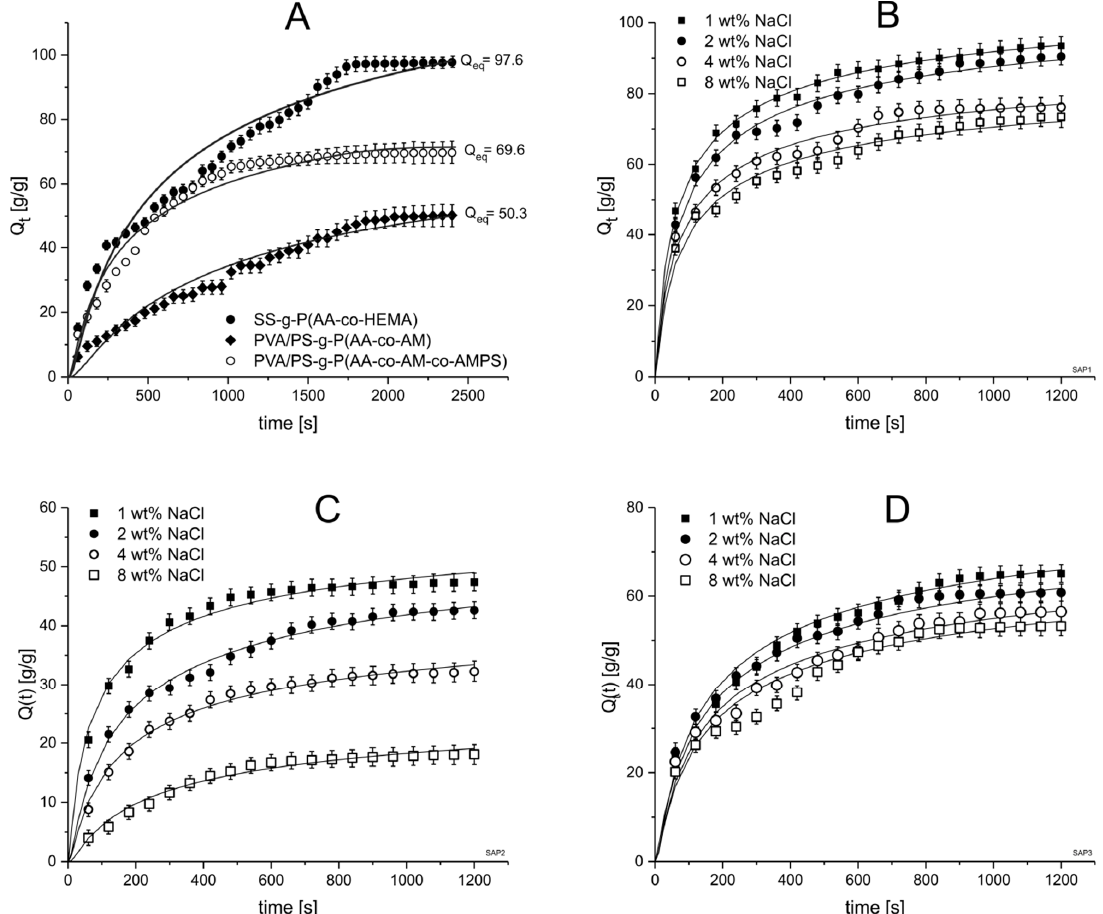
Figure 7. Water absorbency plot of studied polymers in water ( A ) and in different NaCl solutions plotted separately for each polymer: SS-g-P(AA-co-HEMA) ( B ), PVA/PS-g-P(AA-co-AM) ( C ) and PVA/PS-g-P(AA-co-AM-co-AMPS) ( D ). Table 3. The collection of the results of fitting the experimental data to Equation (4) and values of parameter τ calculated from Equation (3).